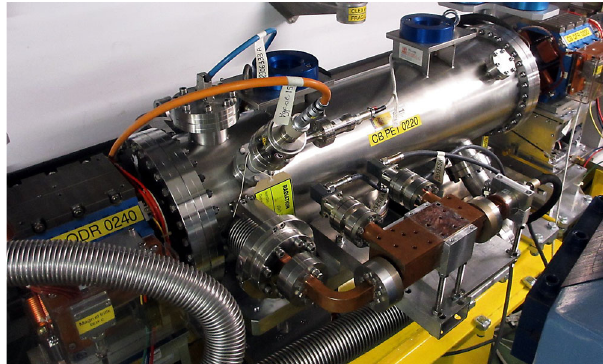
FIG. 4. Measured beam current and RF power for one BPM and one PETS. The beam current has been multiplied by a factor of 2. The shape of the produced power pulse is somewhat different from the beam current pulse, which can be explained by a change in the form factor over the pulse. A reconstruction from the BPM signal and the multibunch form factor based on Eqs. (1), (16), (18), and the signal in Fig. 5 is shown with red triangles.